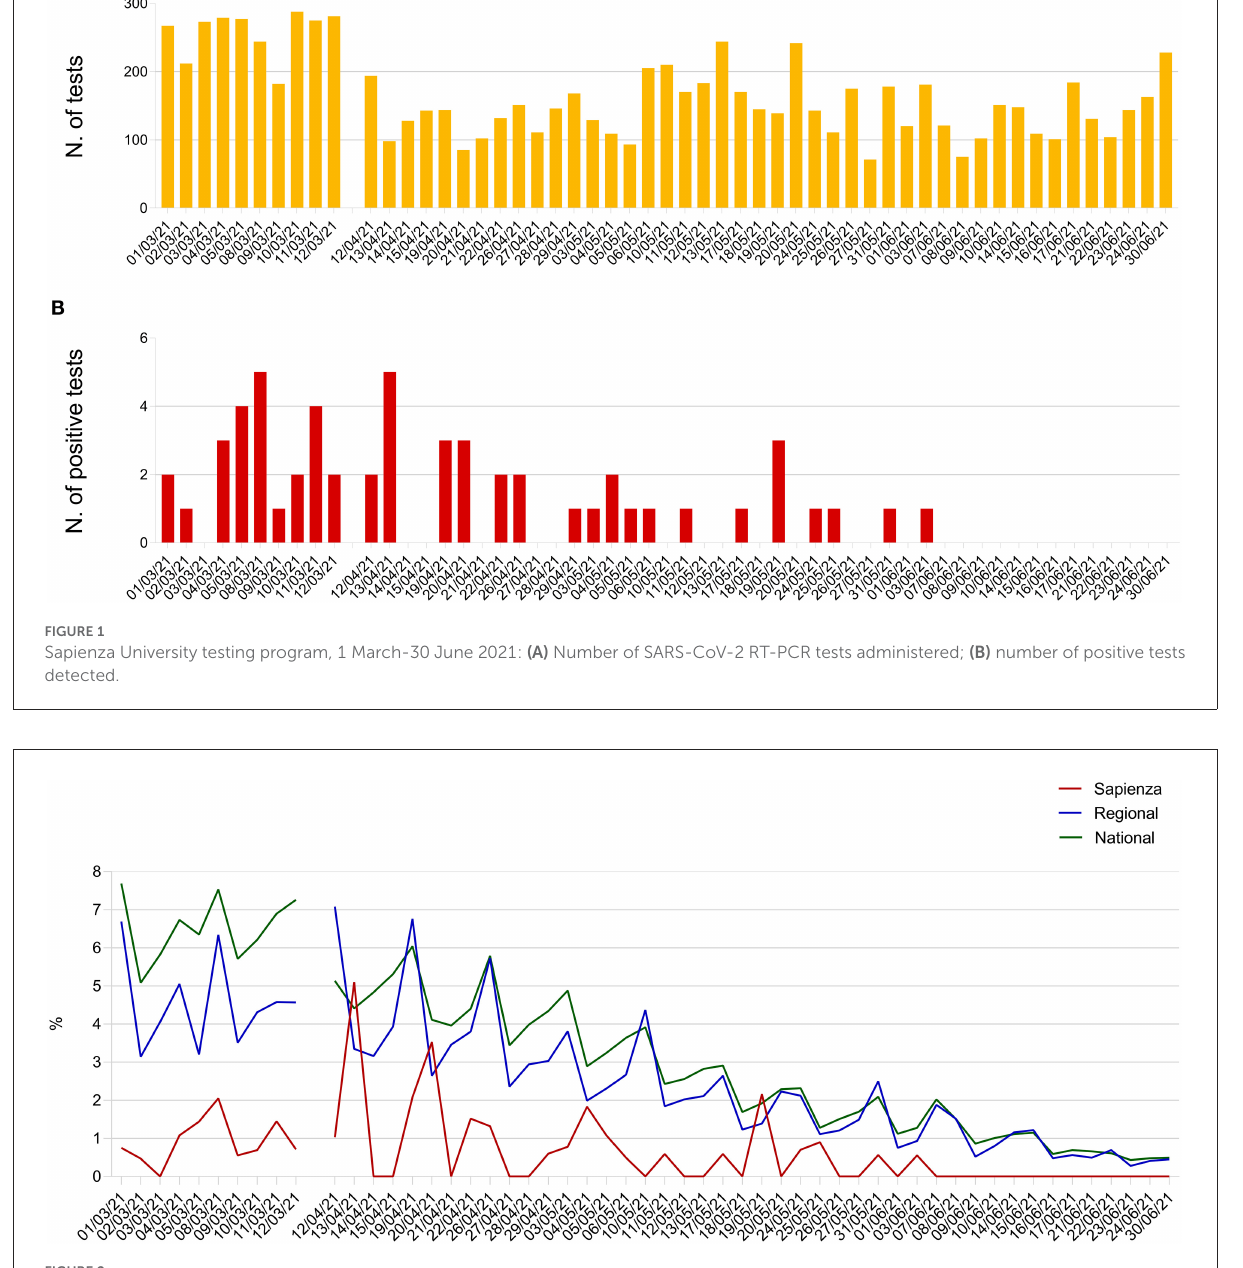
FIGURE2 Daily detection rates of SARS-CoV-2 RT-PCR positive tests registered through the Sapienza University testing program (1 March-30 June 2021) in comparison to regional and national rates of COVID-19 confirmed cases.